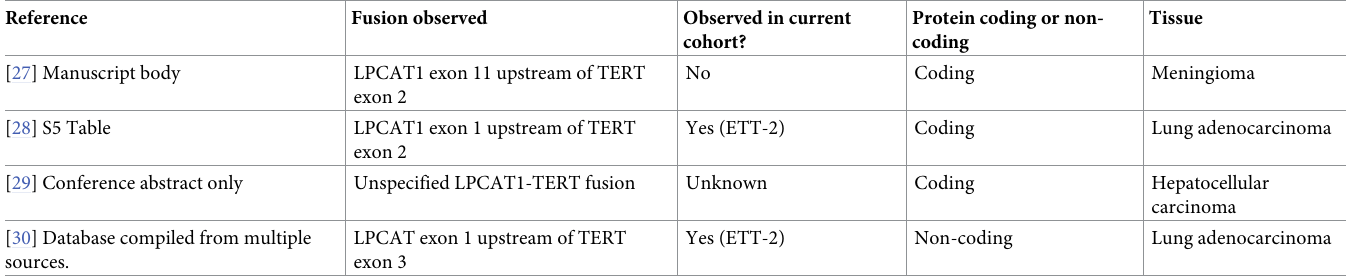
Table 3. Previously reported LPCAT1-TERT fusions and presence in current